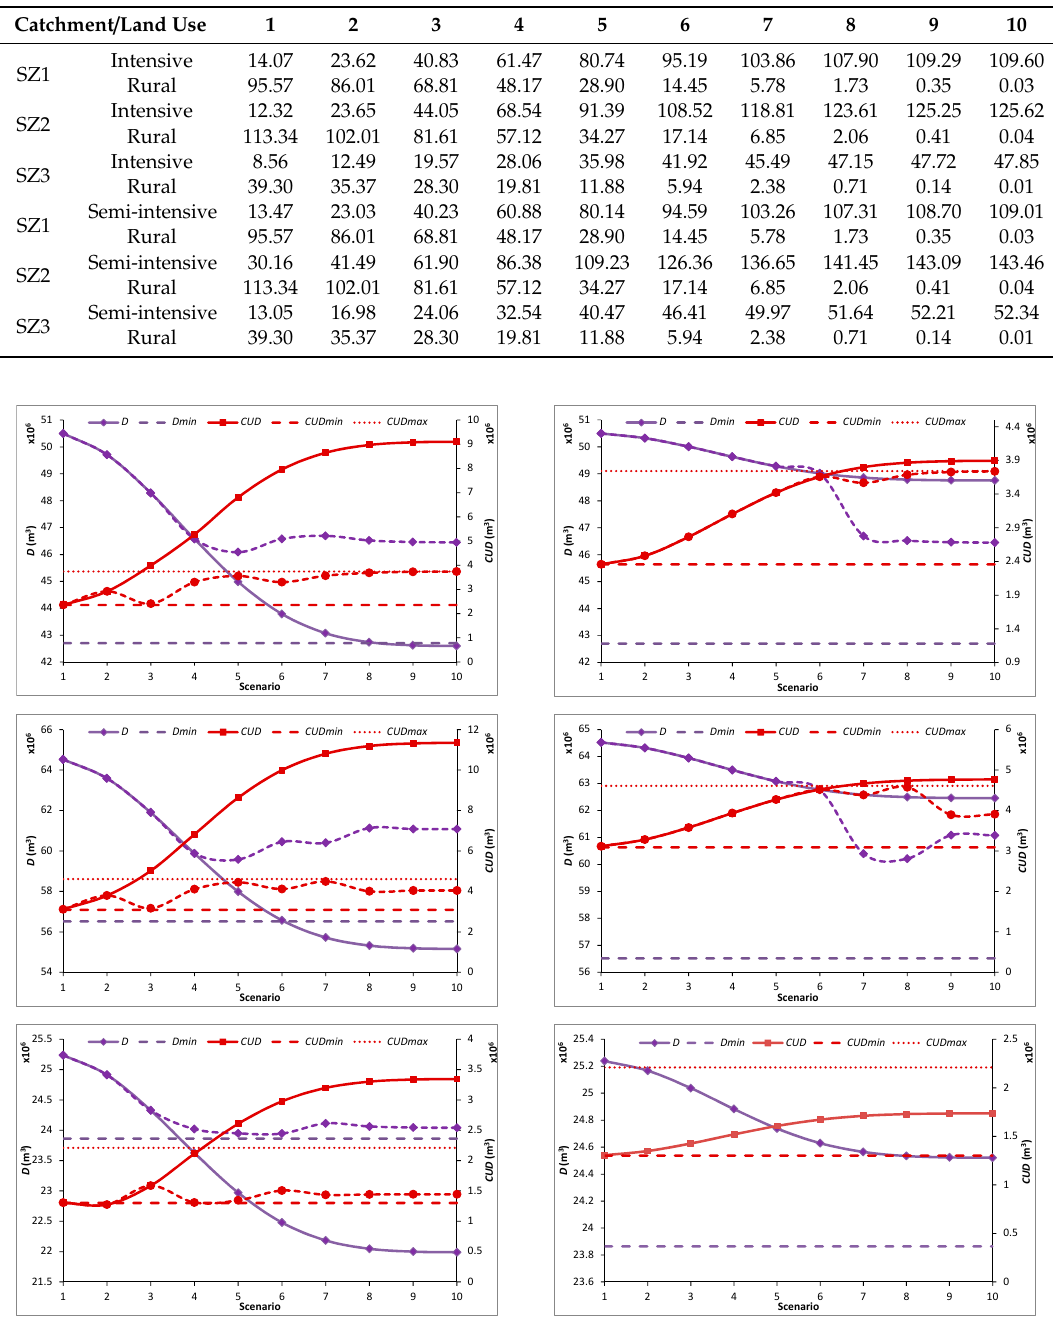
Figure 4. D and CUD results and proposed thresholds for each catchment (SZ1 first row, SZ2 s and SZ3 third), letting either intensive ( left column ) or semi-intensive ( right column ) uses to grow. Continuous lines displayed in Figure 4 represent D and CUD for the optimal SUDs